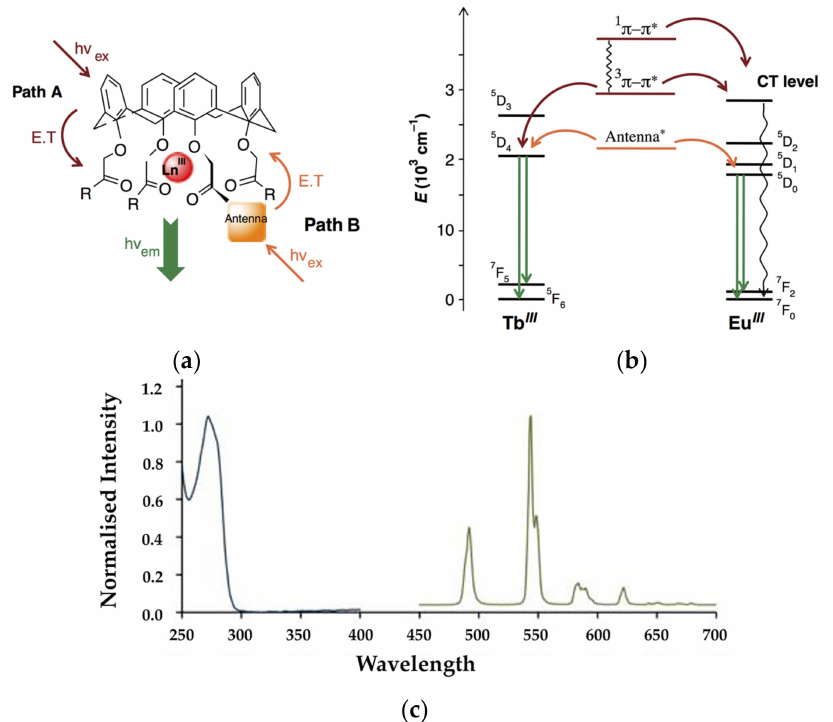
Figure 2. ( a ) Lanthanide emission sensitisation process in a typical lanthanoid calixarene complex. Path A for Ln = Tb and Path B for Ln = Eu. ( b ) Jablonski diagram for the sensitisation of lanthanide luminescence using Path A (in red) or Path B (in orange); ( c ) Typical absorption (blue), and emission spectrum (green) for a terbium calixarene complex showing the line-like emission from the lanthanoid. Figure reproduced with permission of Taylor & Francis Ltd. (www.tandfonline.com) from [14].